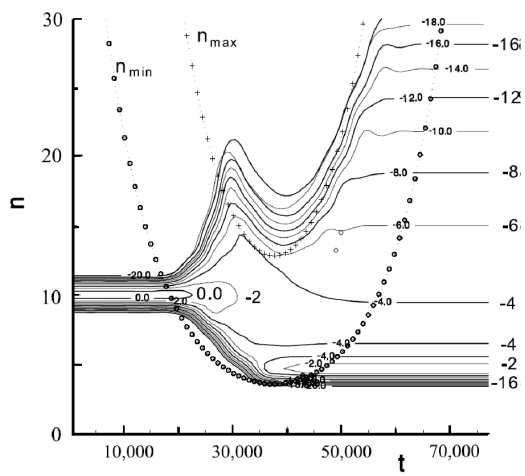
− in nl in a with the impact parameter ρ = 15 and collision energy ρ= 2 and collision energy 10 n = 0